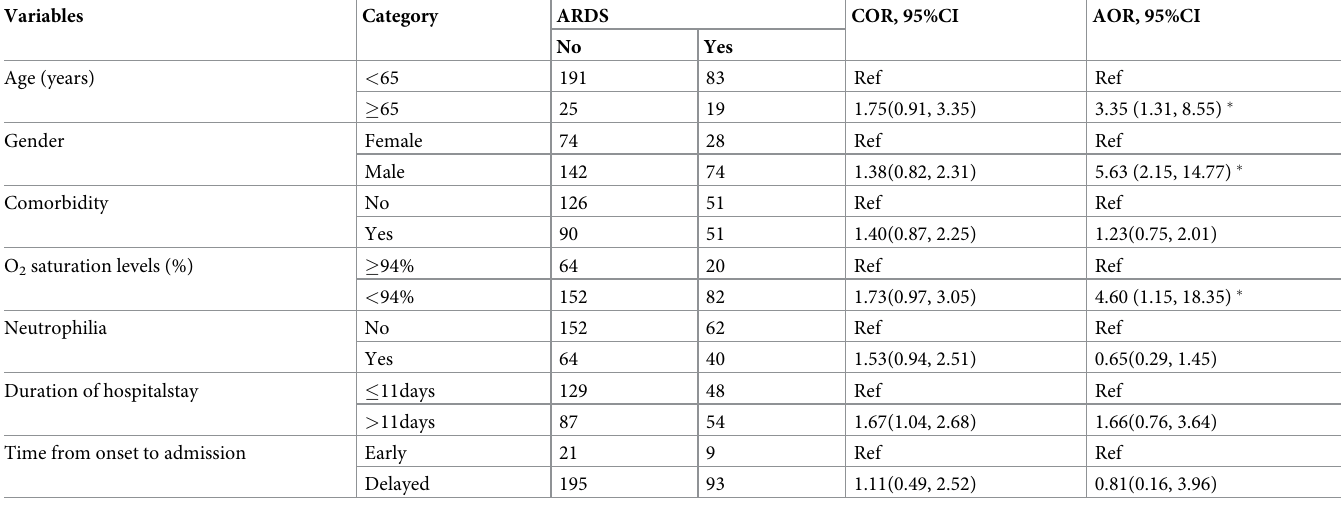
Table 4. Multivariable analysis for acute respiratory distress syndrome among patients admitted with severe COVID-19 at WURH, 2021.